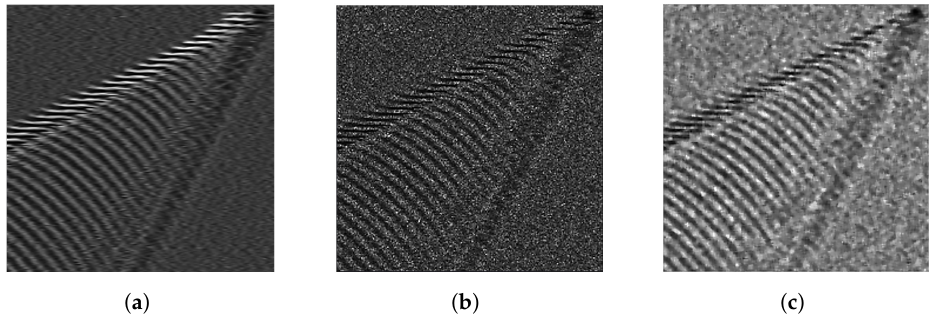
Figure 1. Simulated SAR images ( θ r = 20 ◦ ) of ship wake (Passenger Vessel I) with V s = 8 m/s, D s = 45 ◦ and V w = 3 m/s: ( a ) noise-free I ; ( b ) with noise I n ; ( c ) denoised I d